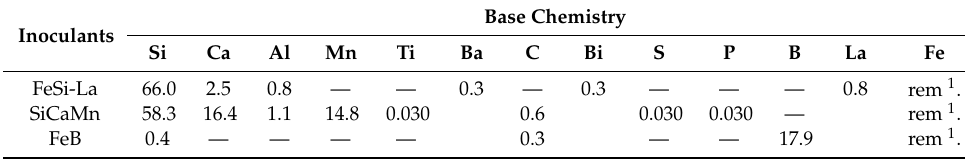
Table 3. Chemical composition of inoculants given in weight